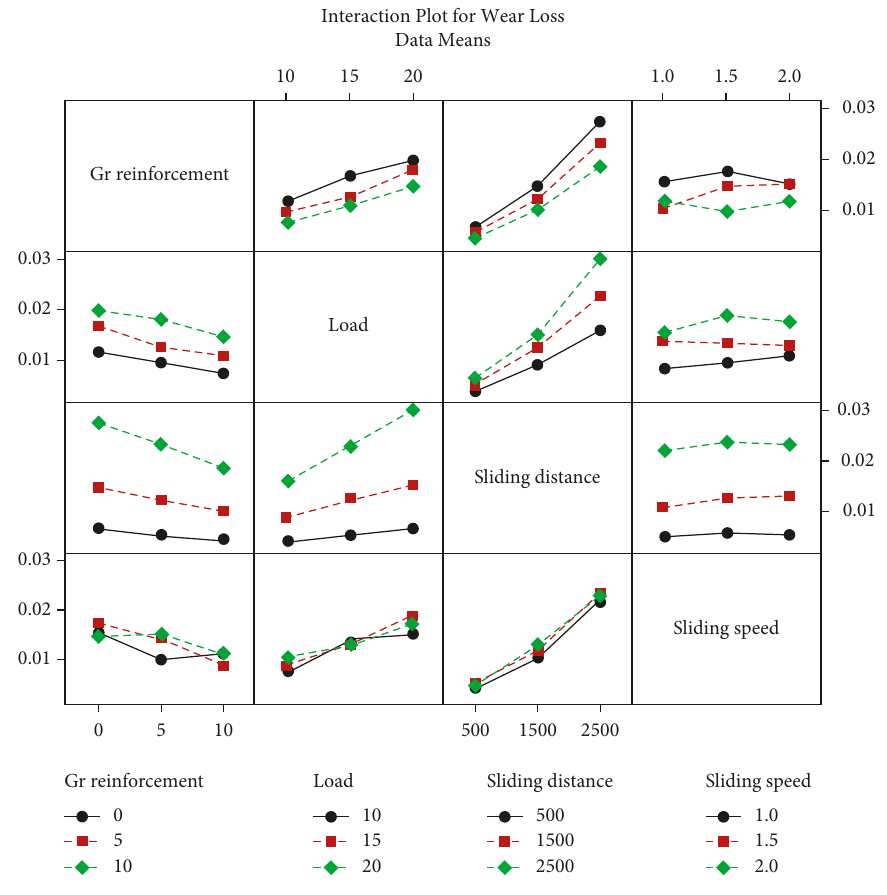
Figure 5: Interaction plots for wear